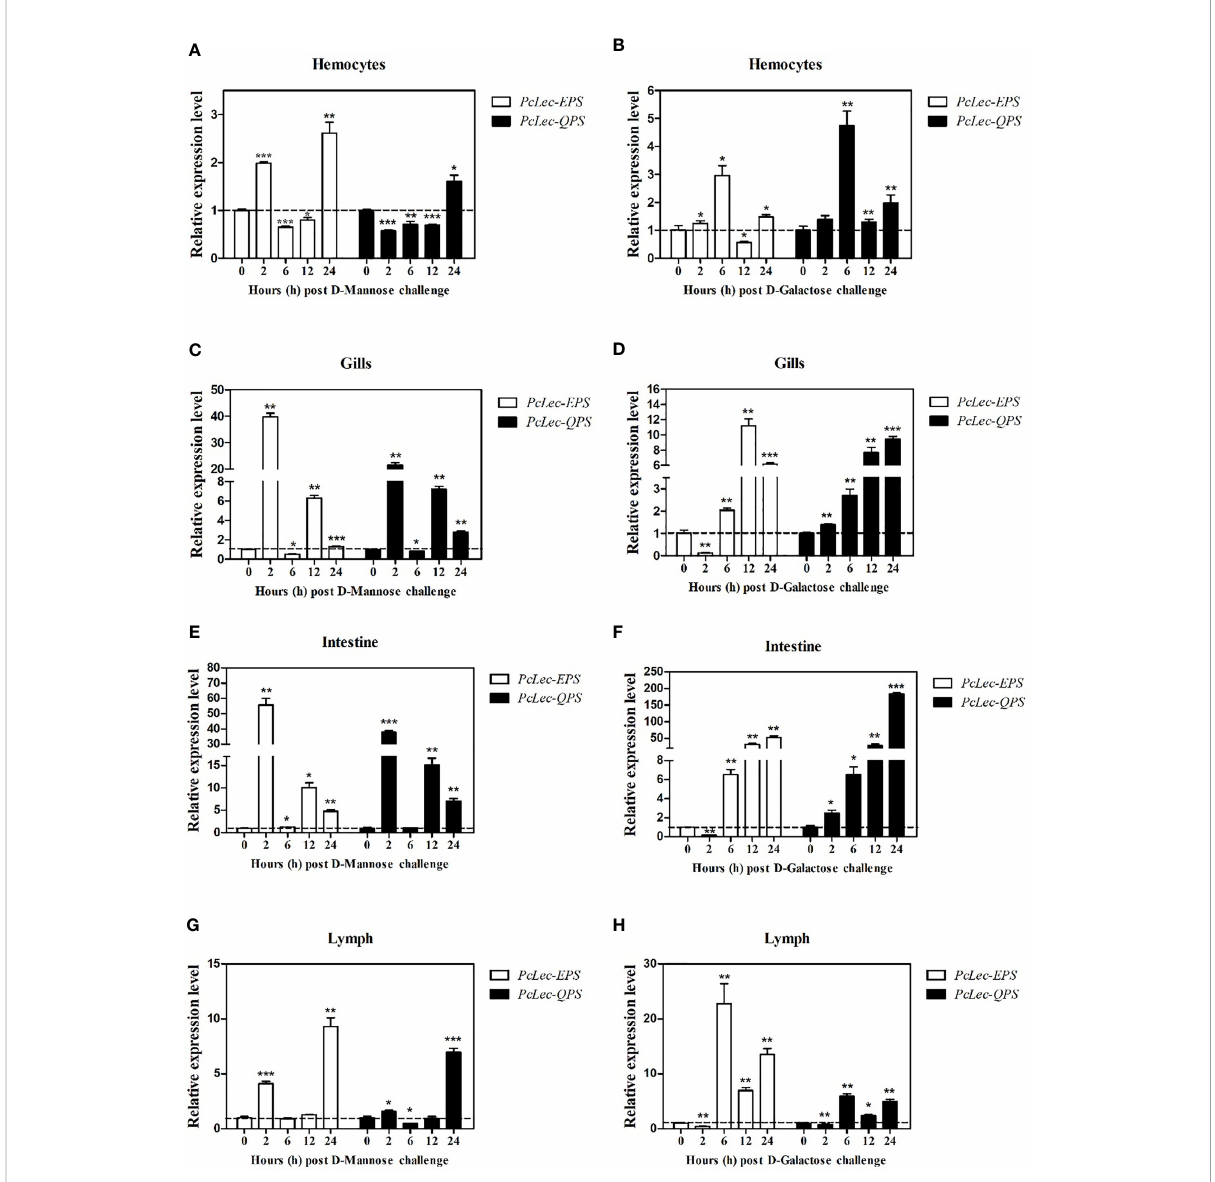
FIGURE 3 Relative transcription levels of PcLec-EPS and PcLec-QPS in the (A, B) hemocytes, (C, D) gills, (E, F) intestine, and (G, H) lymph of D-Mannose or D-Galactose challenged cray fi shes. At 0, 2, 6, 12, and 24 h after D-Mannose or D-Galactose injection, the hemocytes, gills, intestine, and lymph were collected and processed for the RT-qPCR analysis of PcLec-EPS and PcLec-QPS expressions. 18S rRNA was used as an internal control. Data are presented as mean ± SD, N = 5. Asterisks indicate signi fi cant differences (* p < 0.05, ** p < 0.01, and *** p < 0.001) compared to the untreated group (0 h